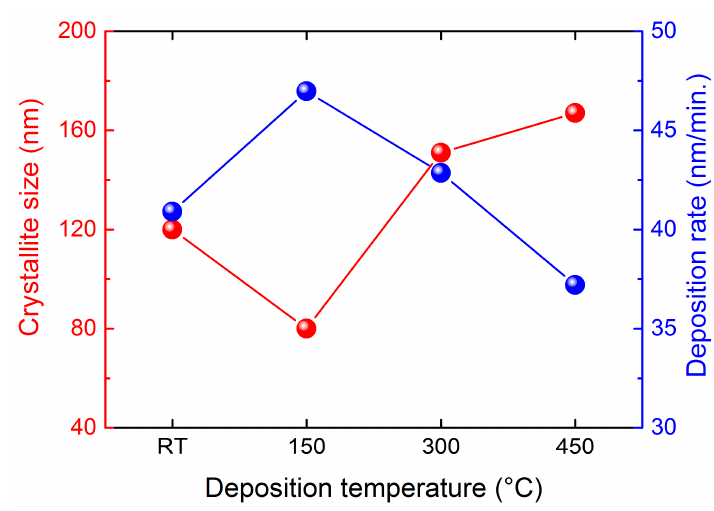
Figure 1. Crystallite size and deposition rate as a function of deposition temperature for the direct current magnetron sputtered Ti films. Deposition rate shows a volcano shape dependence on temperature, while crystallite size has an opposite trend. RT: room temperature.